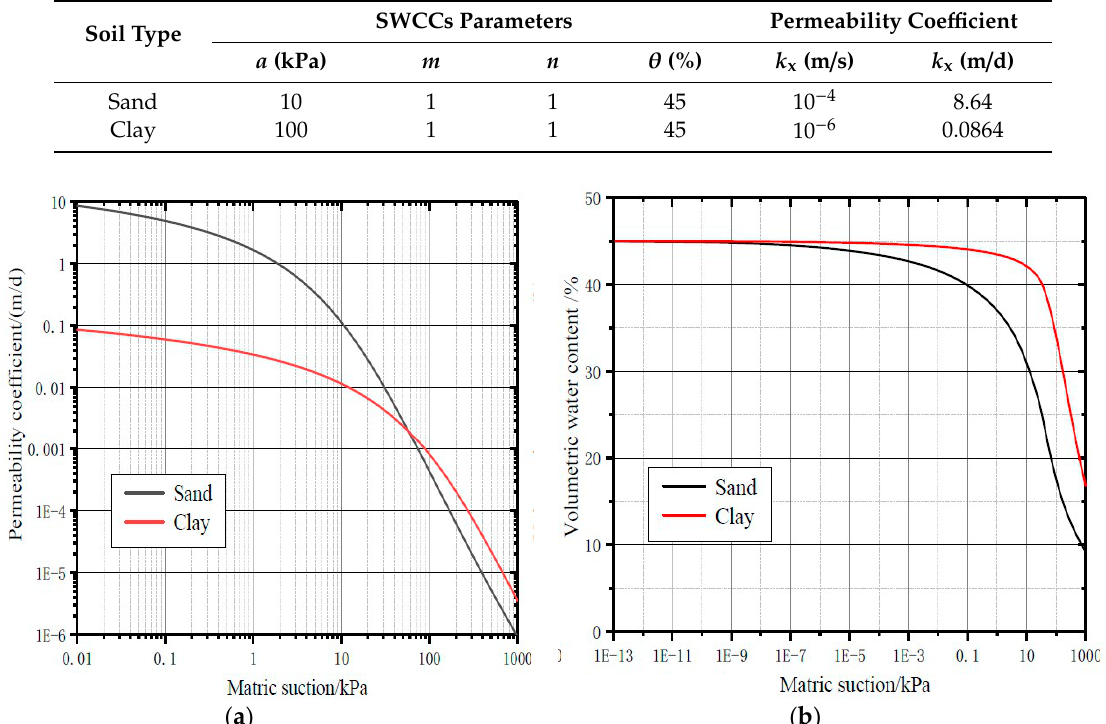
Figure 4. SWCC curves. ( a ) Permeability coefficient function. ( b ) Volume water content function.